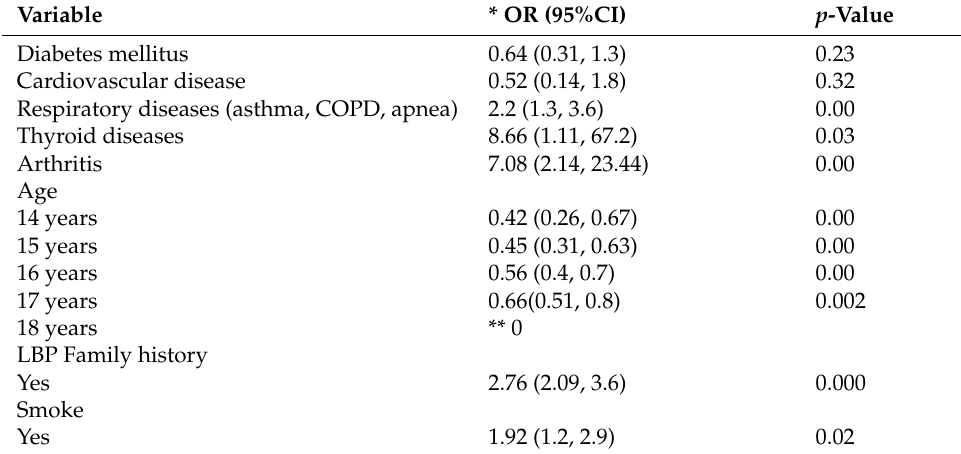
Table 3. Multivariate logistic regression to assess LBP against clinical